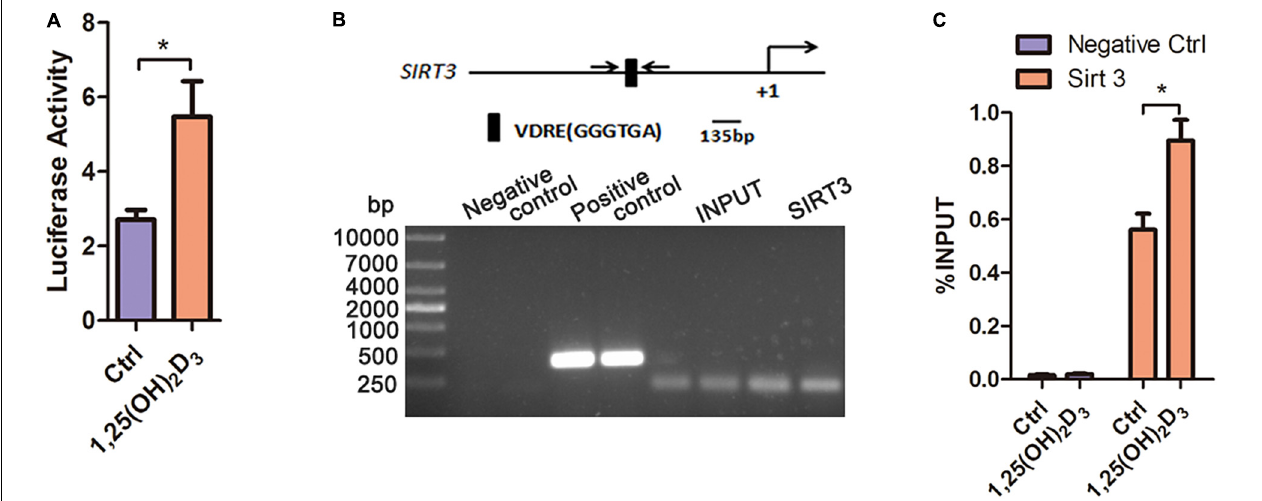
FIGURE 7 | The binding of VDR to the VDRE in the promoter region of Sirt3 increased Sirt3 transcriptional activity. (A) Luciferase assay analysis indicated that 1,25(OH)